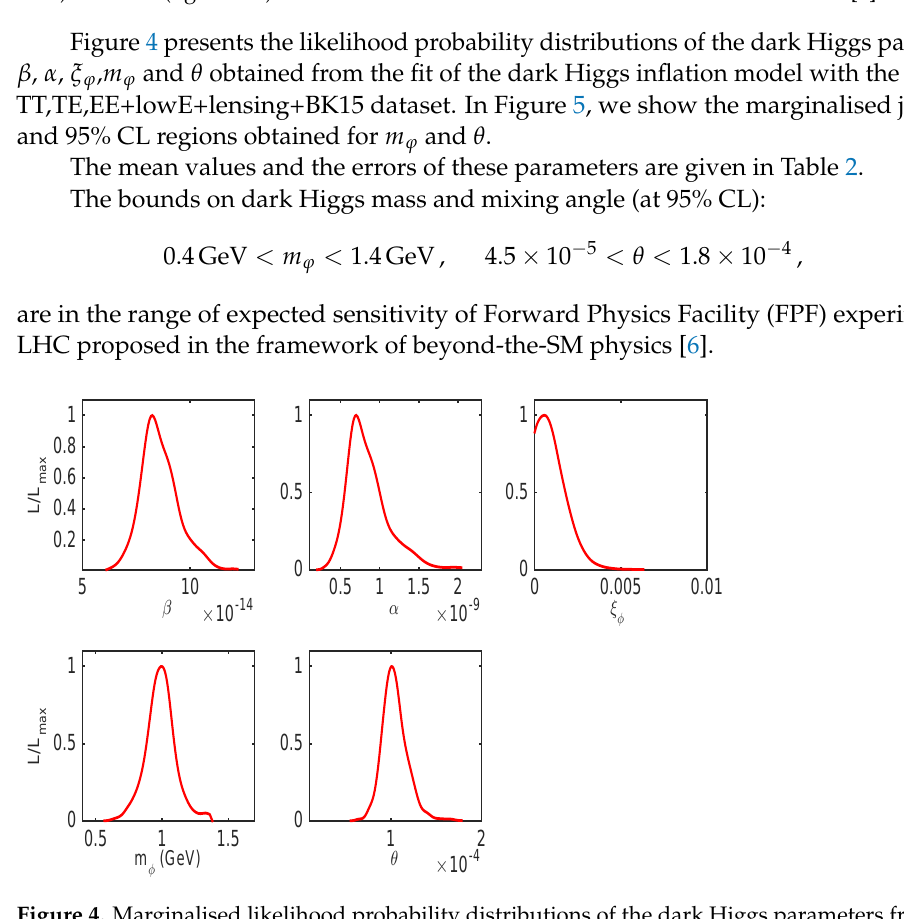
and 95% CL regions obtained for m ϕ and θ .